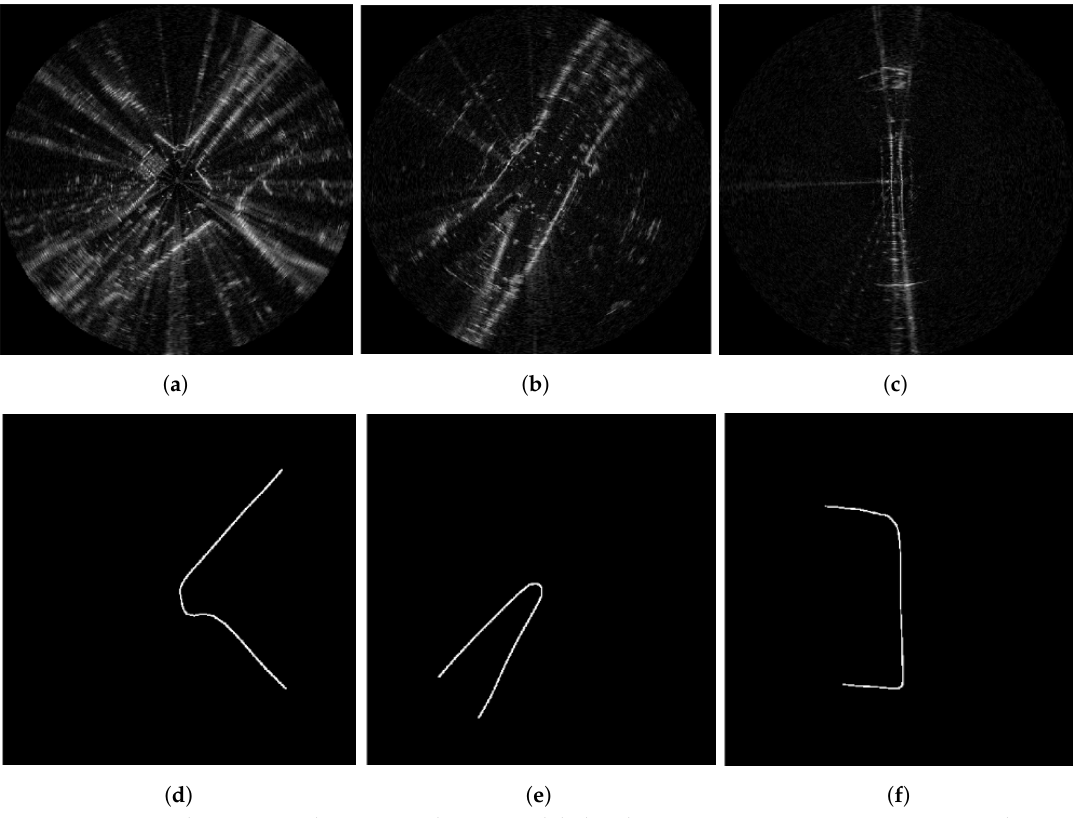
Figure 12. Radar scans and corresponding route labels where open areas are present, prepared as per Section 4.1. In ( a , d ), the test vehicle travels from one narrow street (south-east) to another narrow street (north-east) via an open area. In ( b , e ), the vehicle travels around an open area only. In ( c , f ), the vehicle travels from one open area (south) to another open area (north) via a narrow